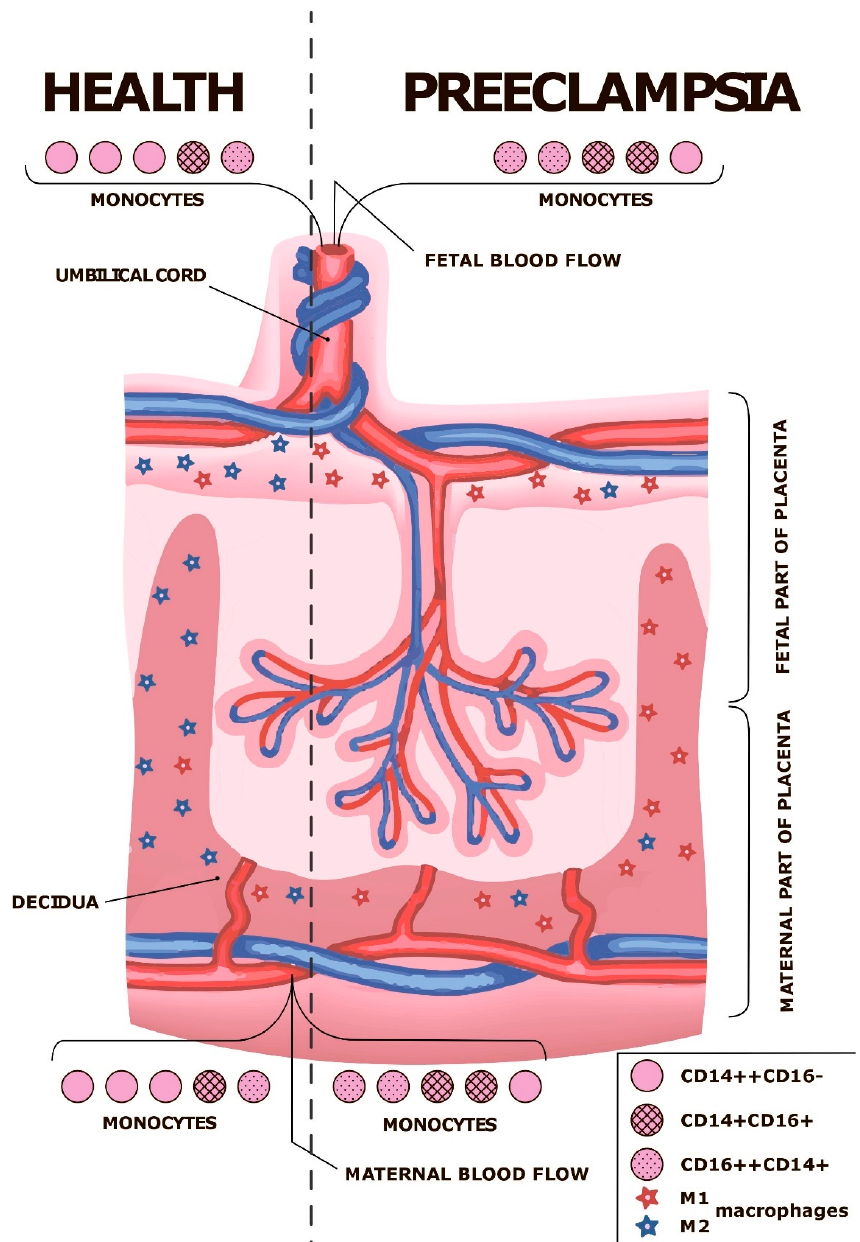
Figure 1. Summarizing scheme. Monocyte–macrophage system in decidua, fetal and maternal placental parts and blood flow of mother and fetus. Classical (CD14++CD16 − ), non-classical (CD16++CD14+) and intermediate (CD14+CD16+) monocyte populations as well as proinflammatory (M1) and anti-inflammatory (M2) macrophages are shown. Modified from [26] (distributed under CC-BY).